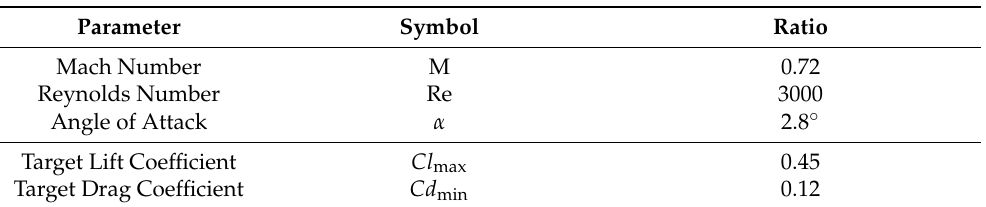
Table 3. The flow conditions utilized in the proposed multipurpose shape optimization for the NACA4418 airfoil.